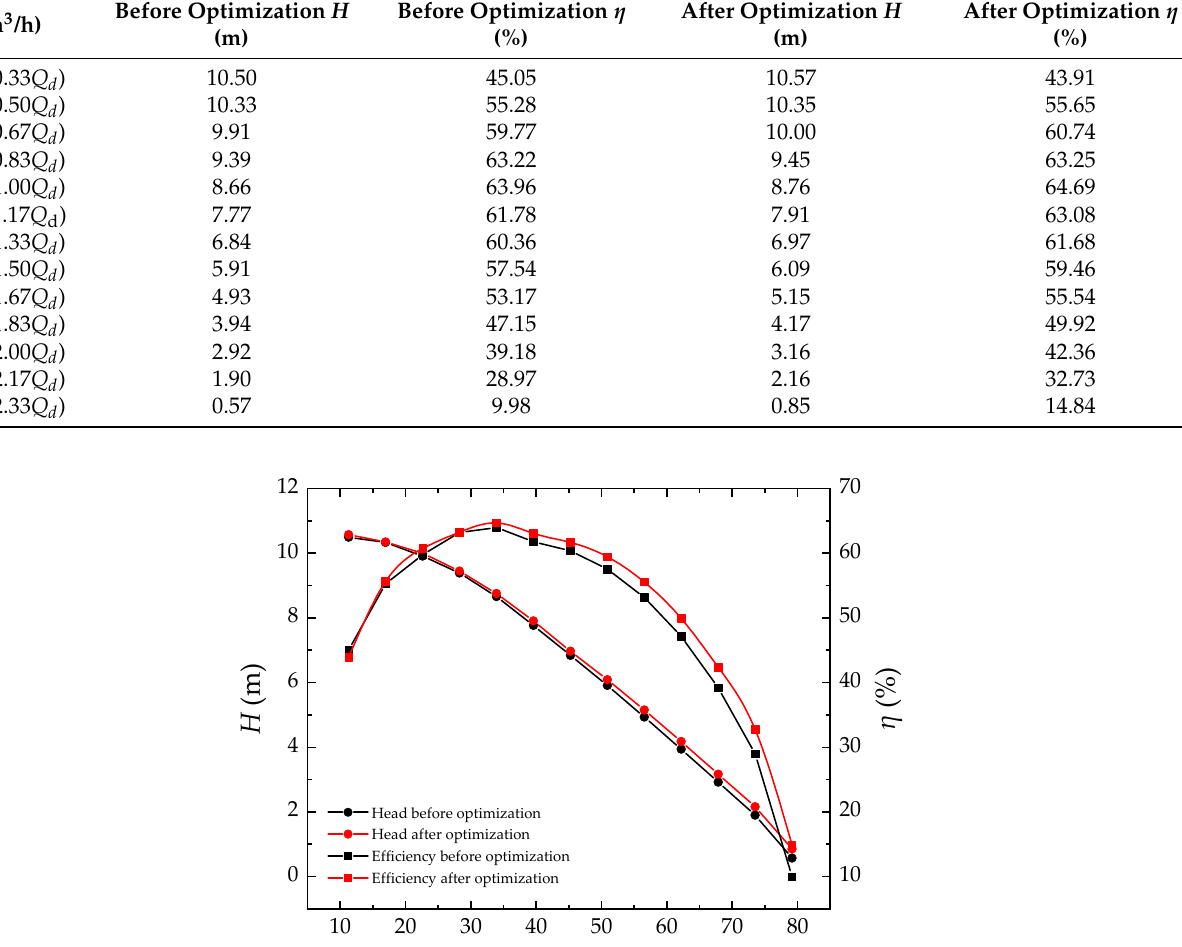
Table 6. Energy characteristics of prefabricated pumping stations before and after optimization.